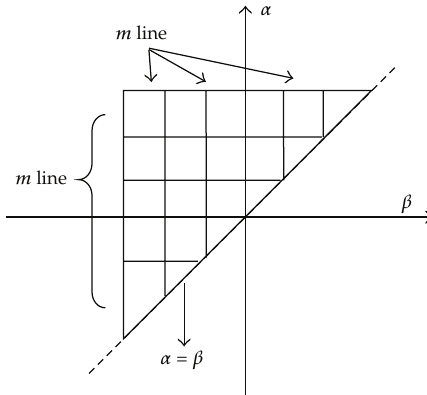
Figure 9: Discrete Preisach plane of Ω